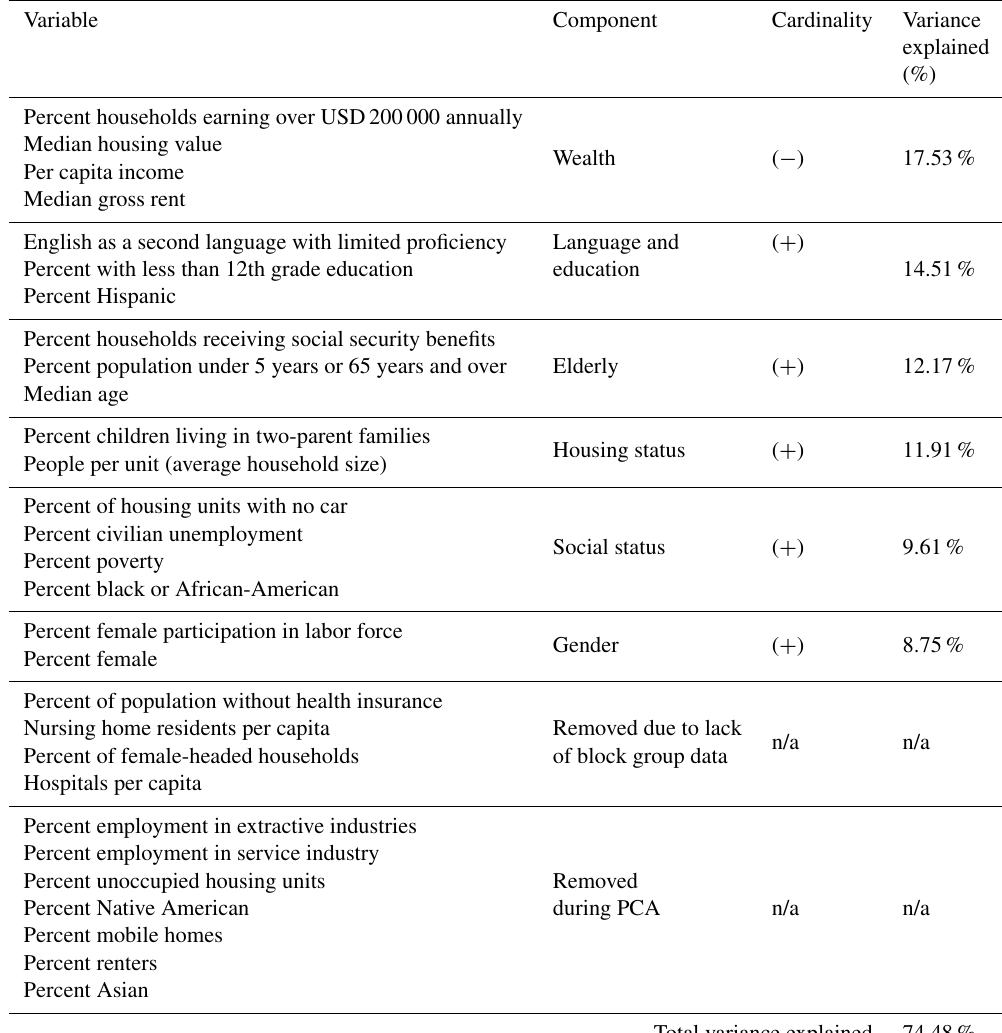
Table 3. Variables included and excluded from the social vulnerability index (SVI) of Austin, Texas, as retrieved from Bixler et al.